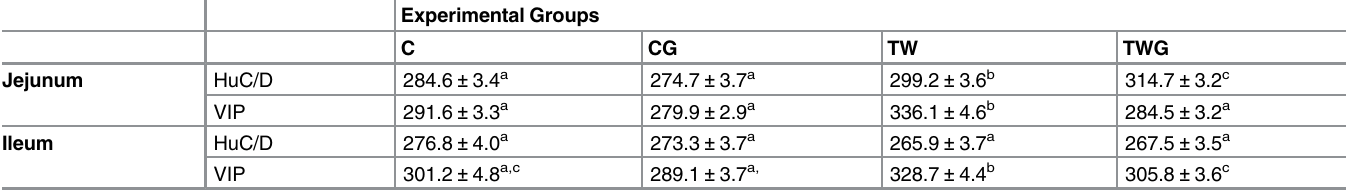
Table 7. Neuronal morphometric analysis of submucosal plexus. Neuronal cell body area ( μ m 2 ) of jejunum and ileum from groups: control (C); control supplemented with 2% L-glutamine (CG); Walker-256 tumor (TW); and Walker-256 tumor supplemented with 2% L-glutamine